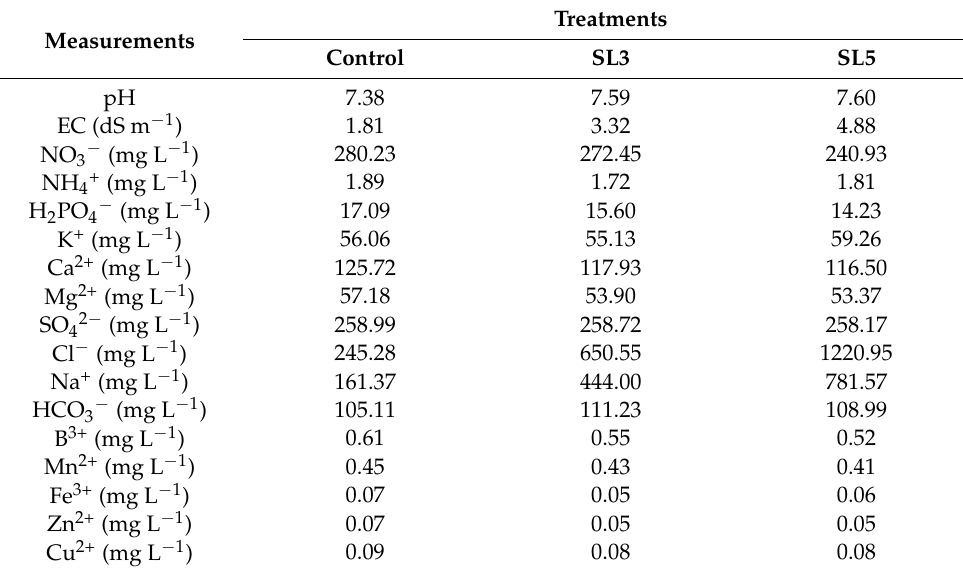
Table 1. pH, electrical conductivity (EC), and ion composition of the nutrient solutions: